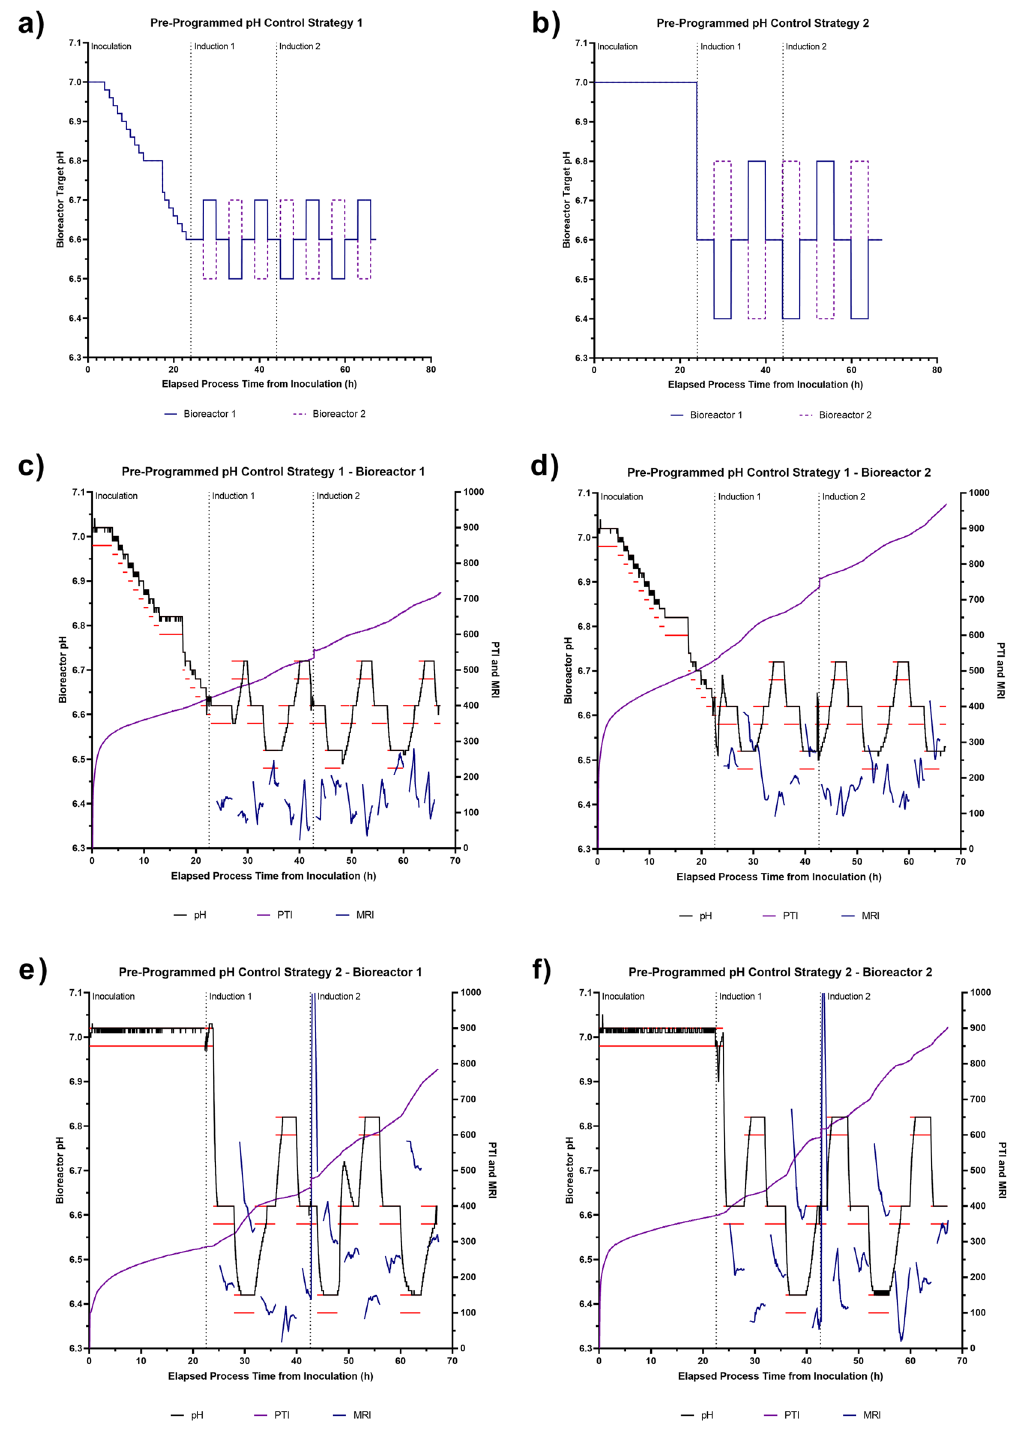
Figure 3. Impact of pre-programmed and autonomous pH parameter control strategies on cell culture activity. ( a ) Pre-programmed pH control strategy 1 and ( b ) strategy 2. PTI and MRI profiles when employing pre- programmed pH control strategy 1 in replicate bioreactors: ( c ) ‘Bioreactor 1’ and ( d ) ‘Bioreactor 2’ and when employing pre-programmed pH control strategy 2 in replicate bioreactors: ( e ) ‘Bioreactor 1’ and ( f ) ‘Bioreactor 2’. ( g ) PTI and MRI traces obtained when employing autonomous pH control strategy 1 and ( h ) strategy 2. In all panels, horizontal red lines indicate pH dead-band and vertical dashed black lines indicate key process